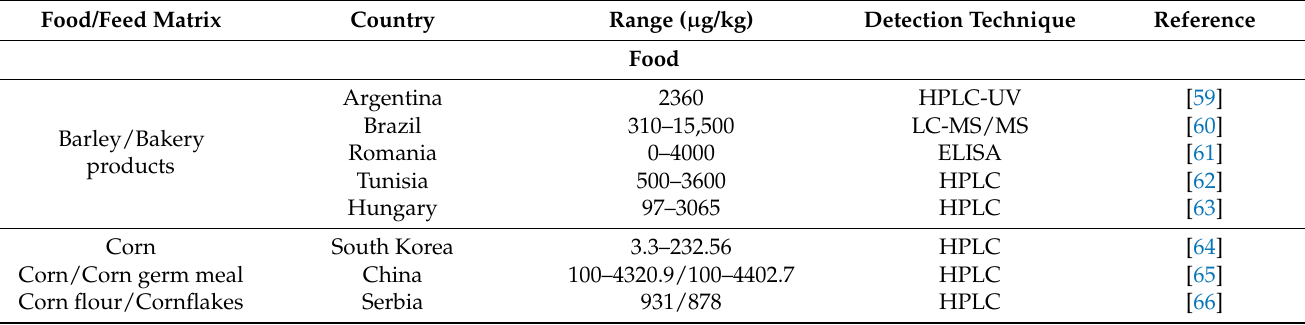
Table 1. Occurrence of Deoxynivalenol in food and feed around the